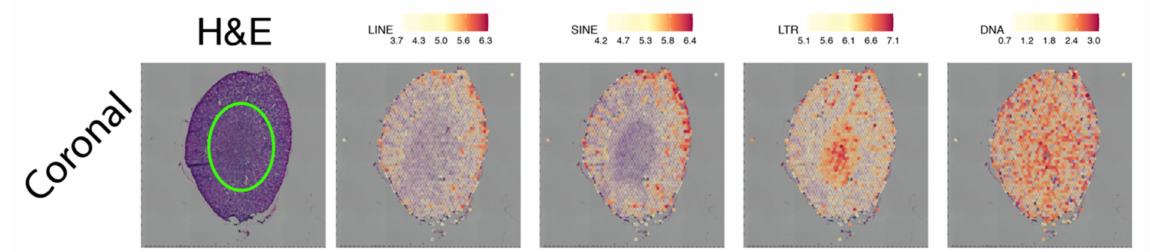
Figure 4. TE expression by class in the adult mice kidney, coronal section. Each TE class is indicated above. Expression levels correspond to log2 normalized counts, with the colour scale indicated at the top of each plot. “H&E”: Hematoxylin and Eosin-stained tissue. A green oval has been added to the H&E figure to highlight the